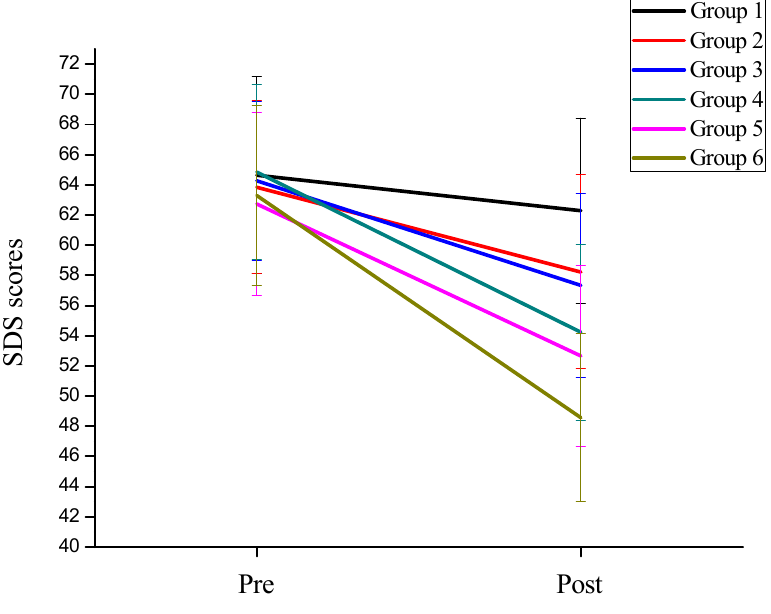
Figure 4. The trend of depression symptoms of the six groups of subjects.